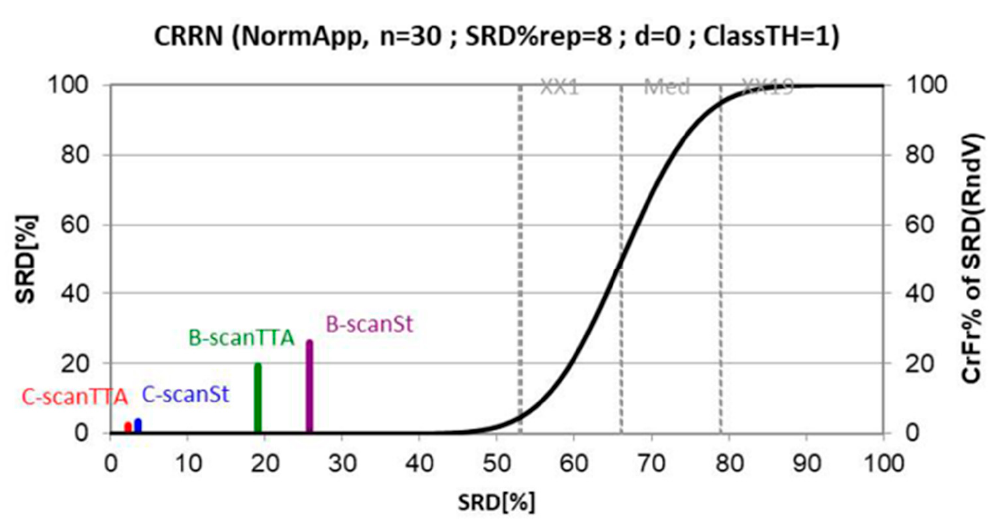
Figure A1. Fair comparison of folds results with sum of ranking differences (SRDs) Figure A1. Fair c omparison of folds results with sum of ranking differences (SRDs) method.